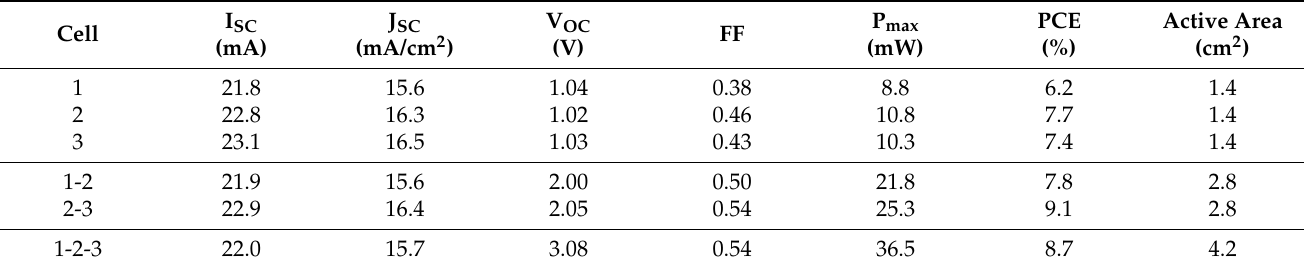
Table 2. Photovoltaic parameter of each single cell and interconnected cells of a PbI 2 -based PSM.